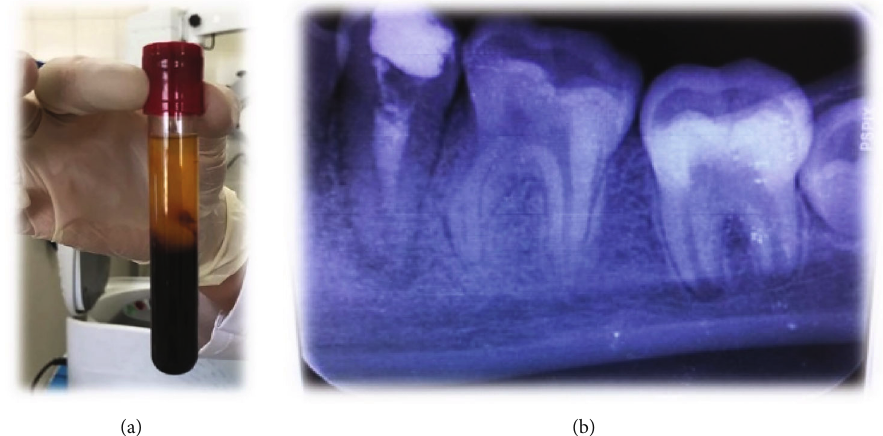
Figure 2: (a) Preparation of A-PRF+; (b) placing MTA on A-PRF+ and a temporary fi